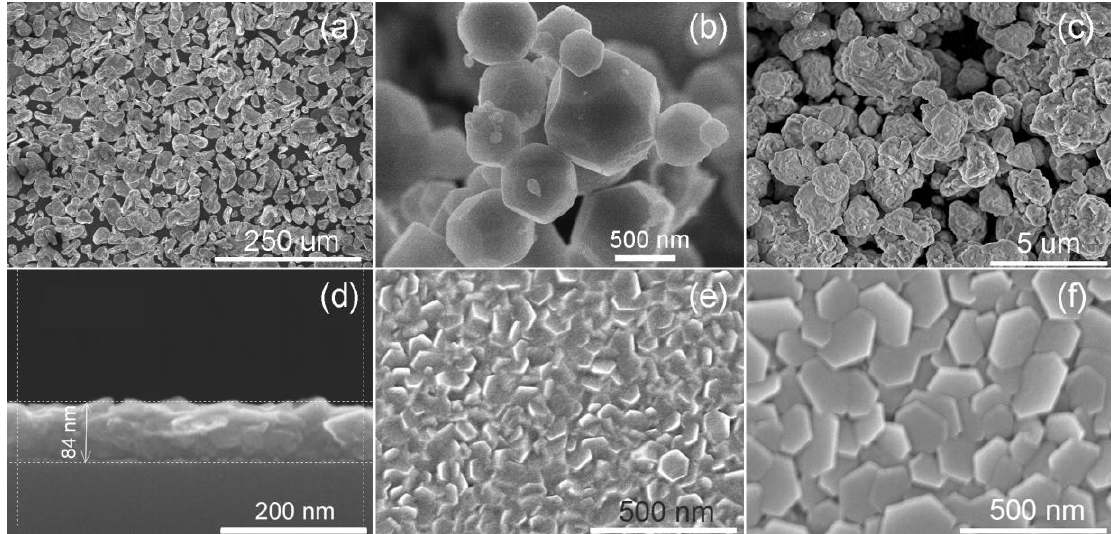
Figure 4. SEM images of ( a ) 325 mesh Mg, ( b ) Mg nanoparticle sample, ( c ) milled Mg 50 Co 50 bcc alloy, ( d ) cross-section observation of Mg thin film without Pd layer, ( e ) top view of Mg thin film without Pd layer and ( f ) top view of Pd capped Mg thin film. Adapted with permission from [44], Copyright Elsevier, 2014.